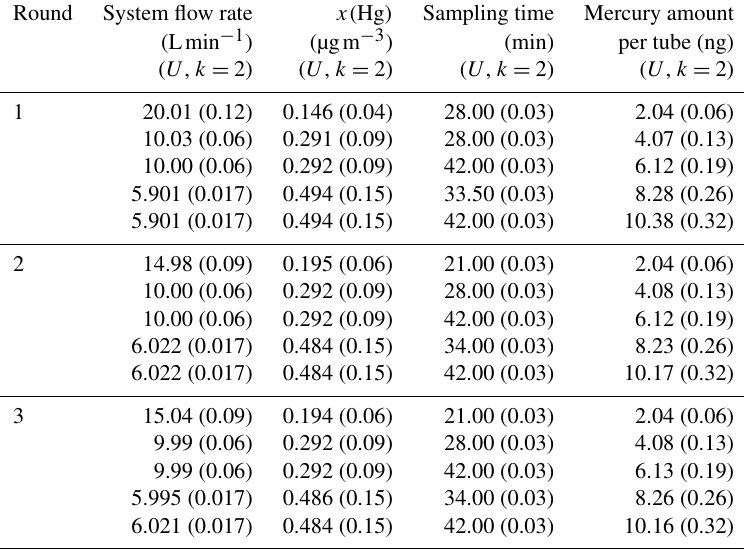
Table 2. Parameters used to sample sorbent tubes from the primary mercury gas standard for the first